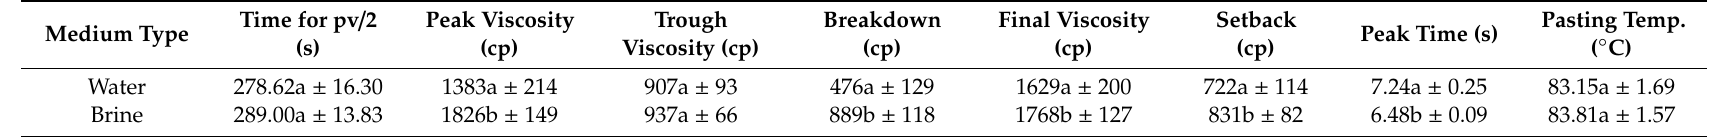
Table 5. Average values of RVA parameters at 130 ◦ C for 13 bean flours using distilled water and brine.